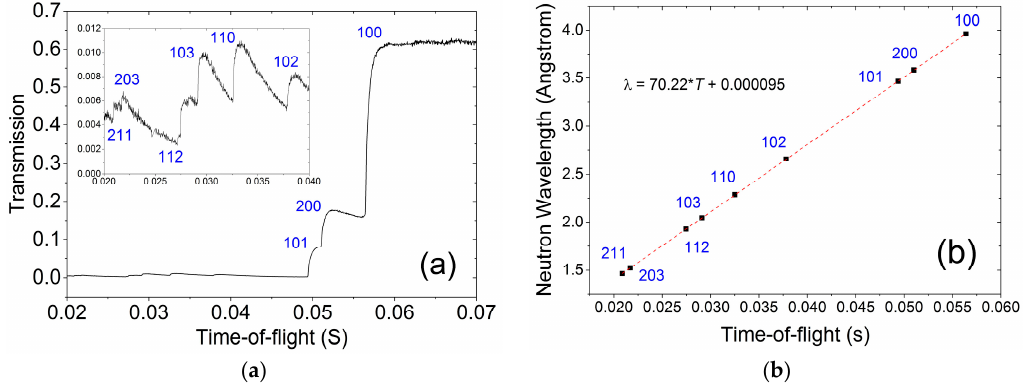
Figure 8. TOF flight path calibration using a beryllium sample. ( a ) Indexed TOF spectrum for a large region of interest of the sample; ( b ) plot of the nominal Be Bragg edge positions versus measured Bragg edge positions. The slope yields the flight path; the intercept yields the TOF offset, according to Equation (1).